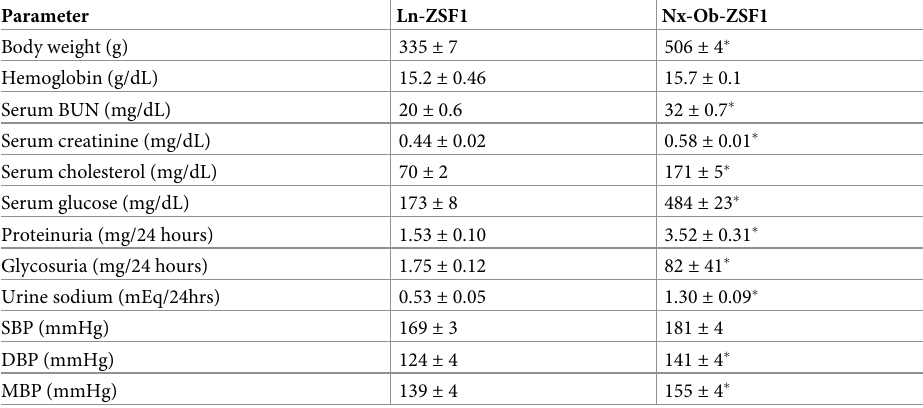
Table 1. Baseline characteristics of Ln-ZSF1 and Ob-ZSF1 rats. Parameter